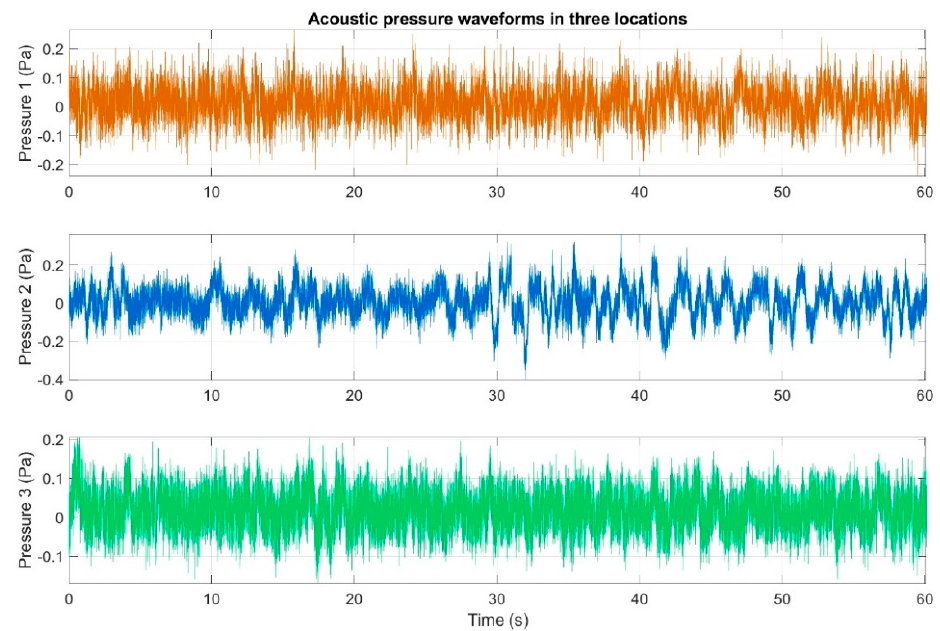
Figure 8. Acoustic pressure waveforms in three different locations measured simultaneously: Orange color—measuring setup number 1; blue color—measuring setup number 2 and green color— measuring setup number 3.